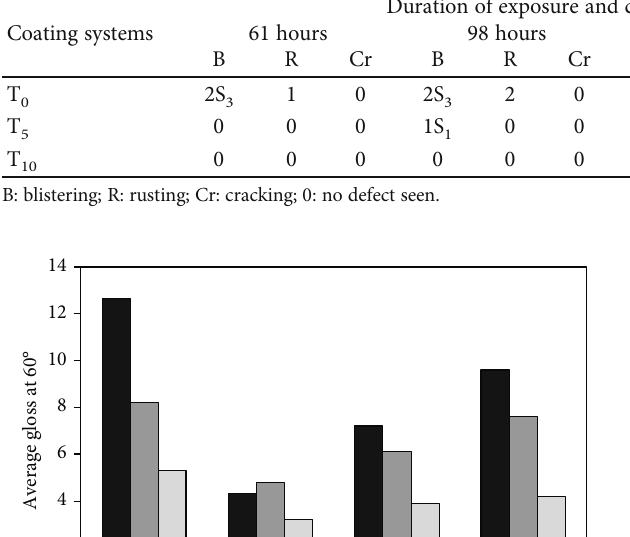
) and the 0 and T ) after natural 5 10